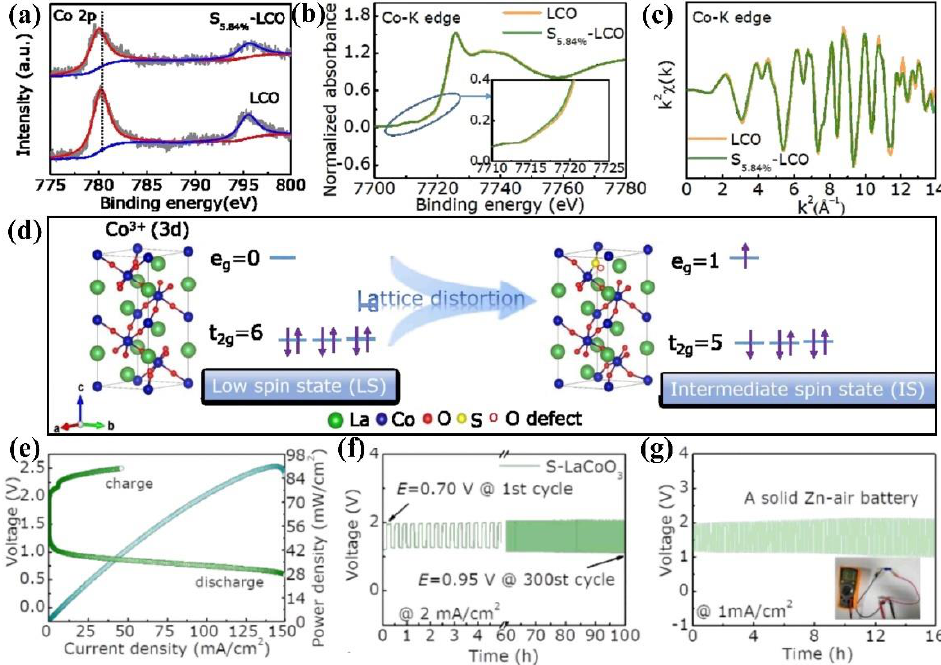
Figure 6. ( a ) XPS spectrum of Co 2p; ( b , c ) Co-K edge XANES and EXAFS spectra of sulfur-doped LaCoO 3 ; ( d ) the evolution of the Intermediate spin state and the transition of electrons from t 2g to e g orbital ( e ) power density; ( f , g ) the stability of aqueous ZABs and flexible ZABs [106]. Copyright 2020, American Chemical Society.